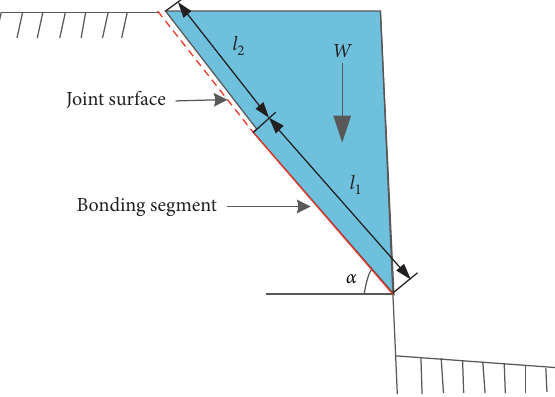
Figure 1: Calculation model of jointed rock.